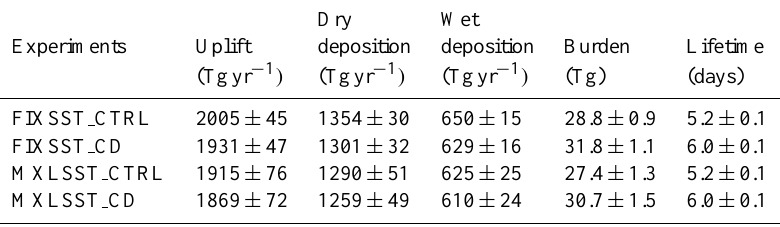
Table 2. Simulated dust climatology in different numerical experiments ∗ .